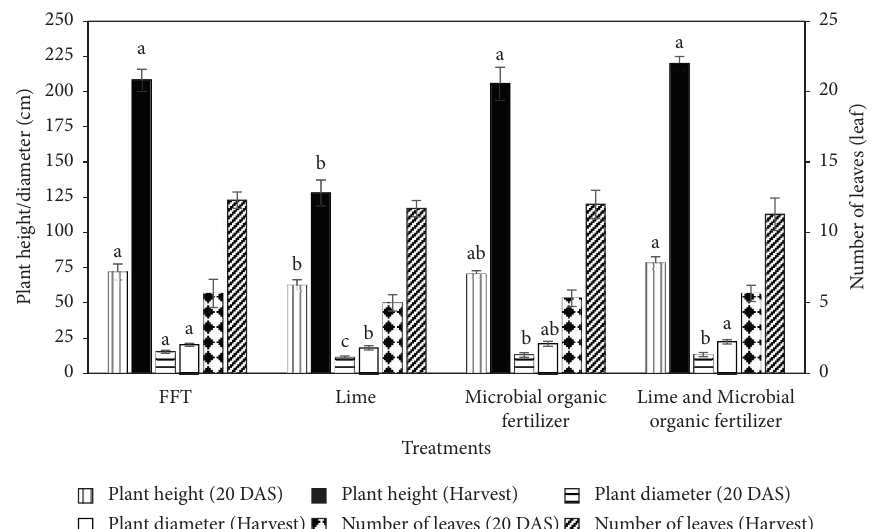
Figure 2: Plant height, plant diameter, and number of leaves of glutinous corn at 20 days after sowing and harvest